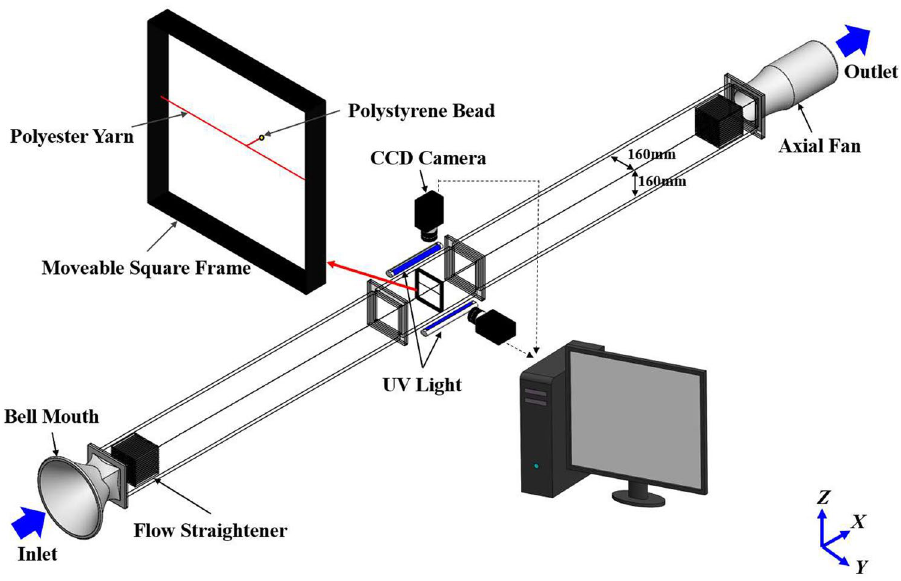
Figure 1. Schematic of the present SPTV experimental